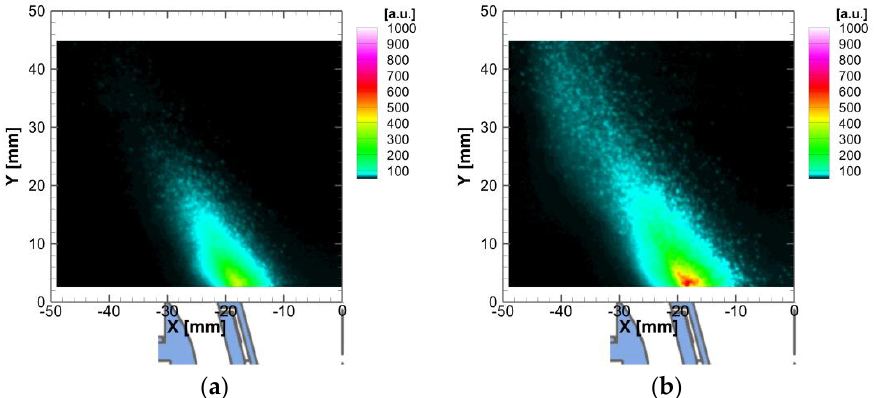
Figure 12. Distributions of kerosene fluorescence at idle condition: ( a ) case P; ( b ) case M. (Illustration of the burner exit section is superimposed beneath the horizontal axis).